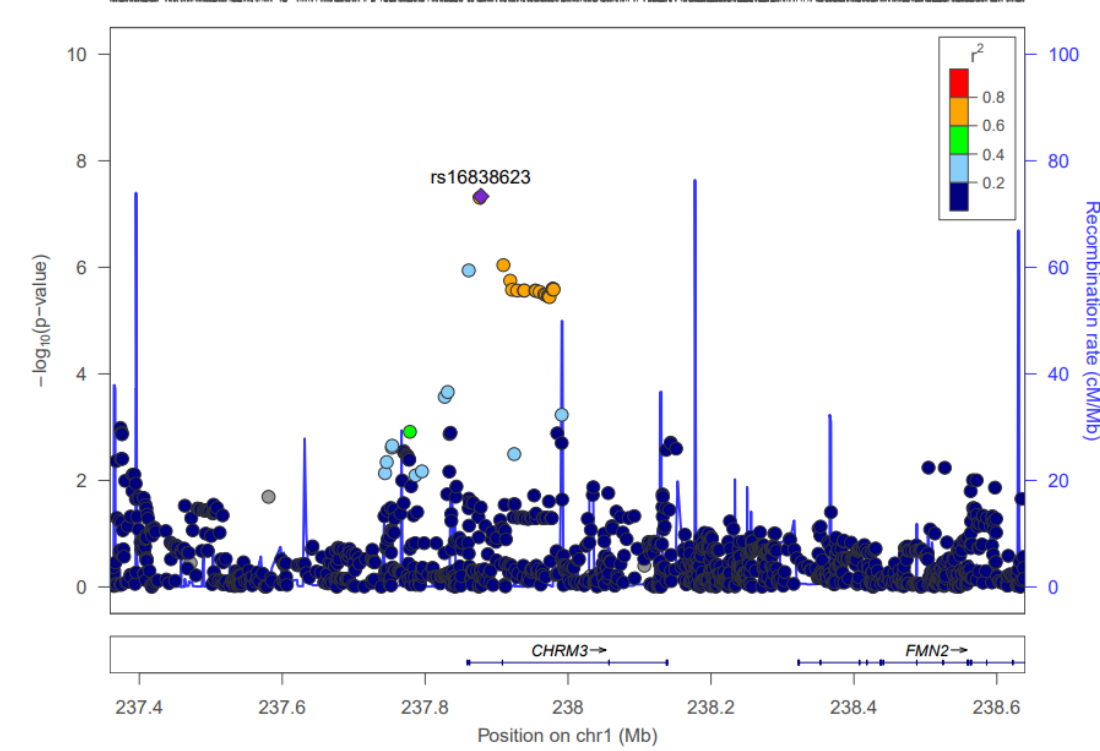
Figure 1. LocusZoom Plot for CHRM3 . This figure shows the linkage disequilibrium and significance pattern of SNPs in and around the CHRM3 gene.